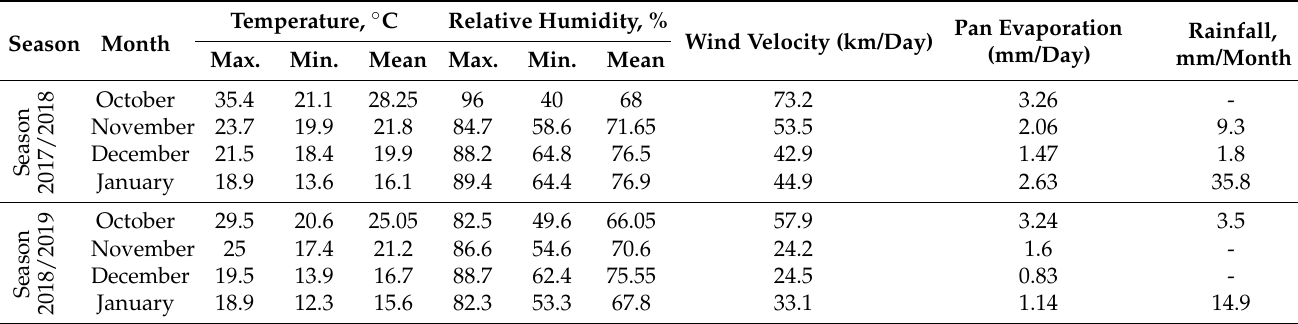
Table 1. Average values of some meteorological date regarding the experimental area during growing seasons (two